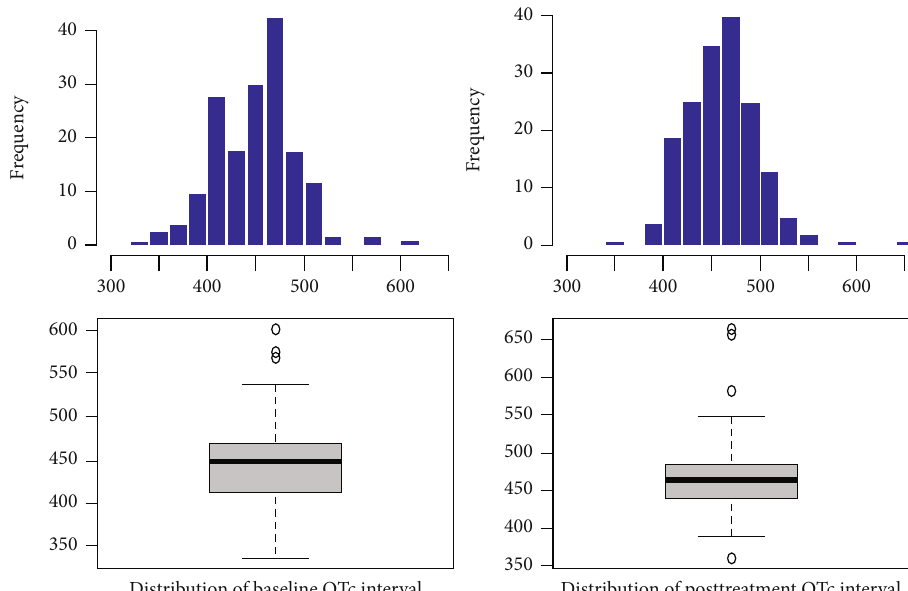
Figure 1: Baseline and posttreatment QTc interval in the monotherapy and combination therapy groups. Hydroxychloroquine alone group mean ± SD values: baseline QTcinterval = 459 : 9 ± 38 : 3 , posttreatment QTcinterval = 462 : 5 ± 43 : 1 , and Δ QTc = 2 : 6 ± 29 : 1 . Hydroxychloroquine and azithromycin group mean ± SD values: baseline QTc interval = 447 : 1 ± 44 : 1 , posttreatment QTc interval = 464 : 3